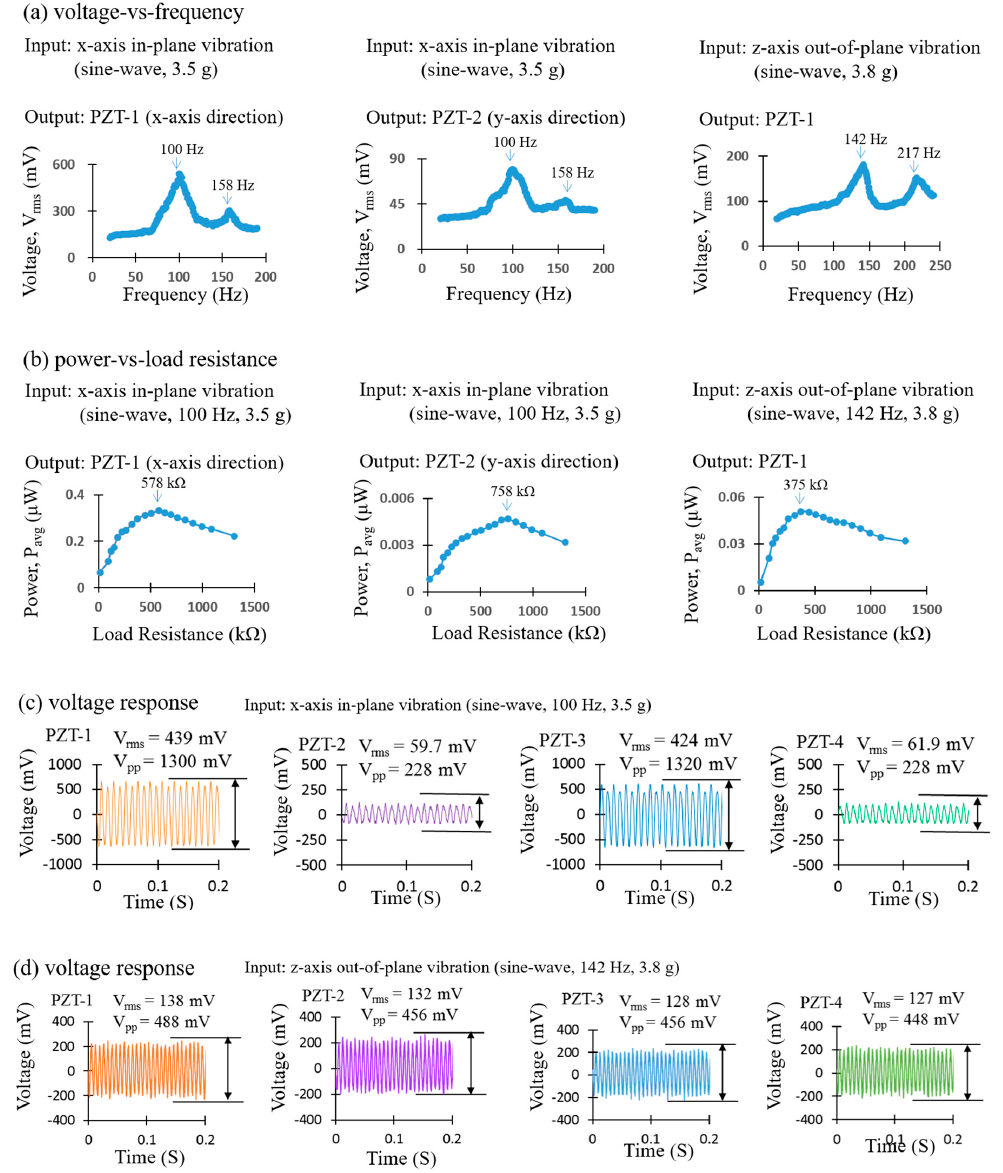
Figure 8. Test results of the piezoelectric/vibrational energy-harvesting function of the AC magnetic sensor: ( a ) voltage vs. frequency plots and ( b ) power vs. load resistance plots. The voltage outputs of each piezoelectric lead-zirconate-titanate (PZT) sheet of the sensor under ( c ) x -axis vibration and ( d ) z -axis